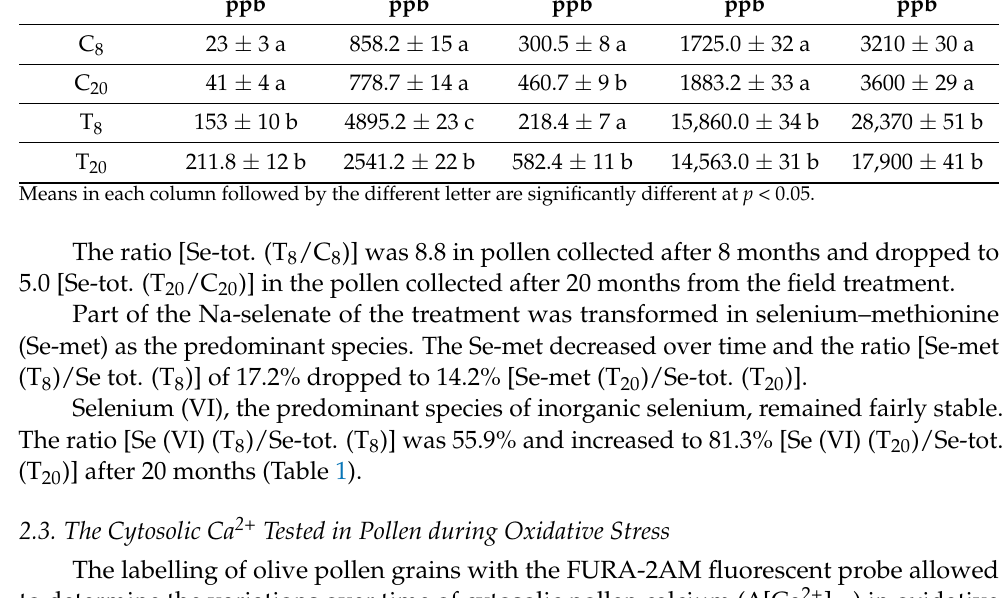
Table 1. Speciation of Se in olive pollen grains collected after 8 and 20 months from untreated (C 8 and C 20 ) and Se-fertilized (T 8 and T 20 ) olive trees in the field. MeSeCys Se Met Se (IV) Se (VI) Se Total ppb ppb ppb ppb ppb C 8 23 ± 3 a 858.2 ± 15 a 300.5 ± 8 a 1725.0 ± 32 a 3210 ± 30 a C 20 41 ± 4 a 778.7 ± 14 a 460.7 ± 9 b 1883.2 ± 33 a 3600 ± 29 a T 8 153 ± 10 b 4895.2 ± 23 c 218.4 ± 7 a 15,860.0 ± 34 b 28,370 ± 51 b T 20 211.8 ± 12 b 2541.2 ± 22 b 582.4 ± 11 b 14,563.0 ± 31 b 17,900 ± 41